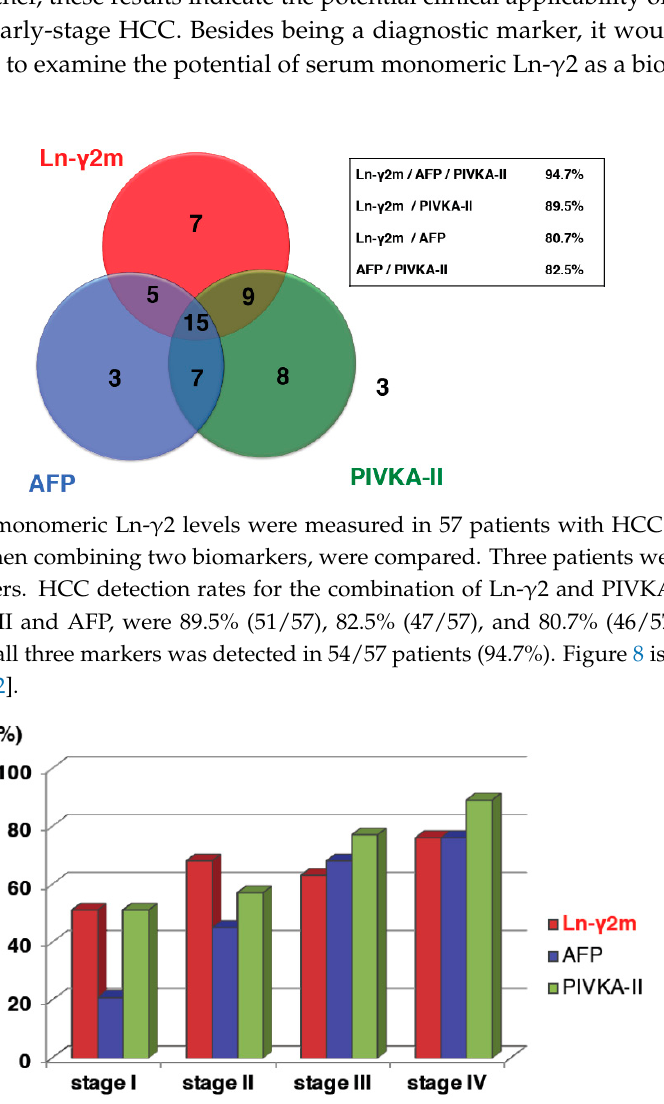
Figure 9. Comparison of the biomarker-positive rate in HCC by tumor stages. Figure 9 is modified from Kiyokawa et al. [22].